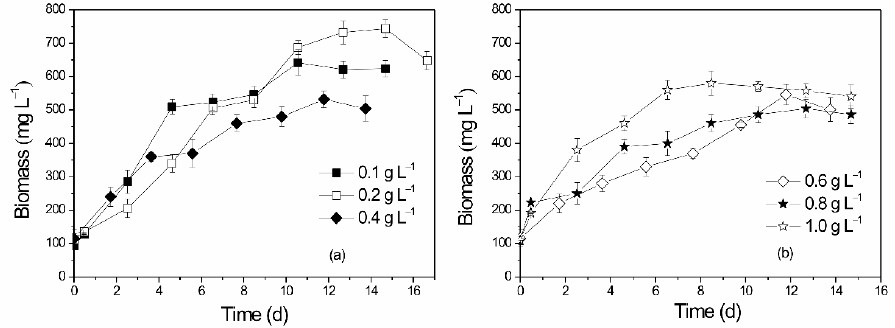
Figure 2. Effect of fertilizer quantities ( a ) 0.1, 0.2, 0.4 g L − 1 , ( b ) 0.6, 0.8, 1 g L − 1 on biomass production of T. striata . Table 2. Nutrient reduction rates, lipid content, biomass productivity and specific growth rates achieved in all substrates